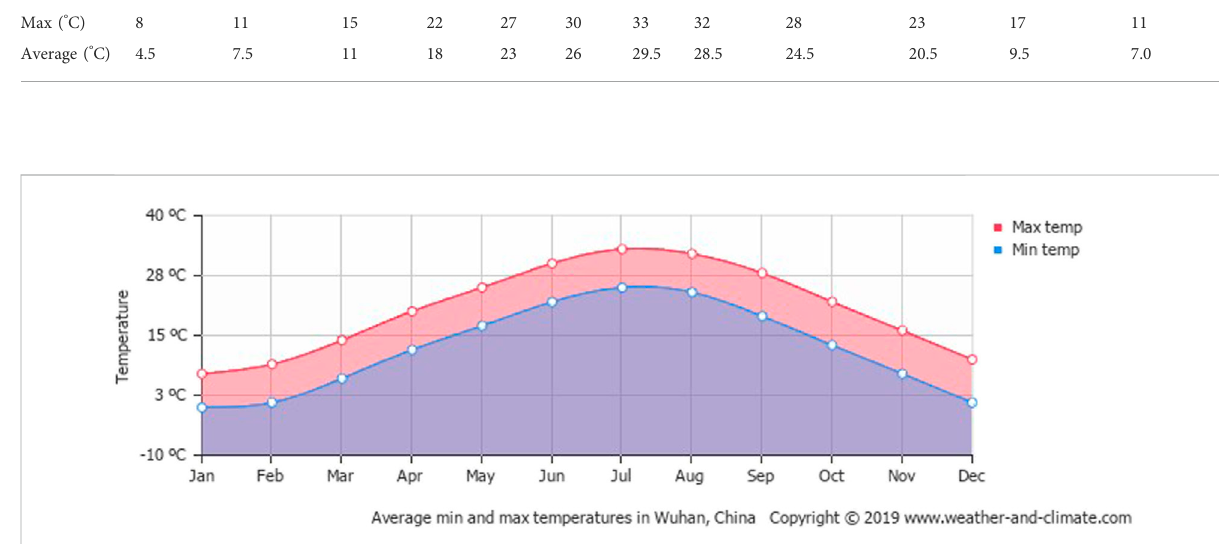
FIGURE 1 Average minimum and maximum temperature over the year (W&C and Climate, 2020).